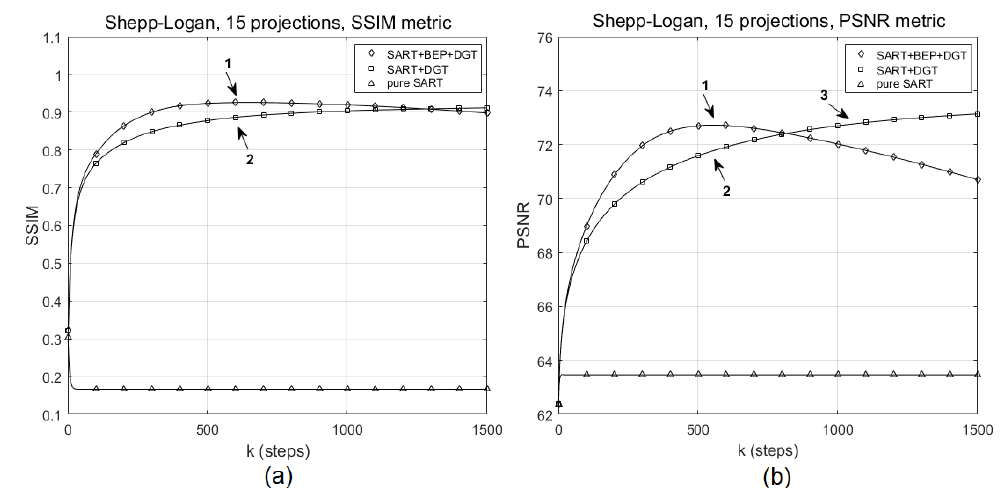
Figure 5. Evolution of ( a ) SSIM and ( b ) PSNR values for the reconstruction of the Shepp–Logan phantom with 15 projections for pure SART, SART+DGT, and SART+BEP+DGT.